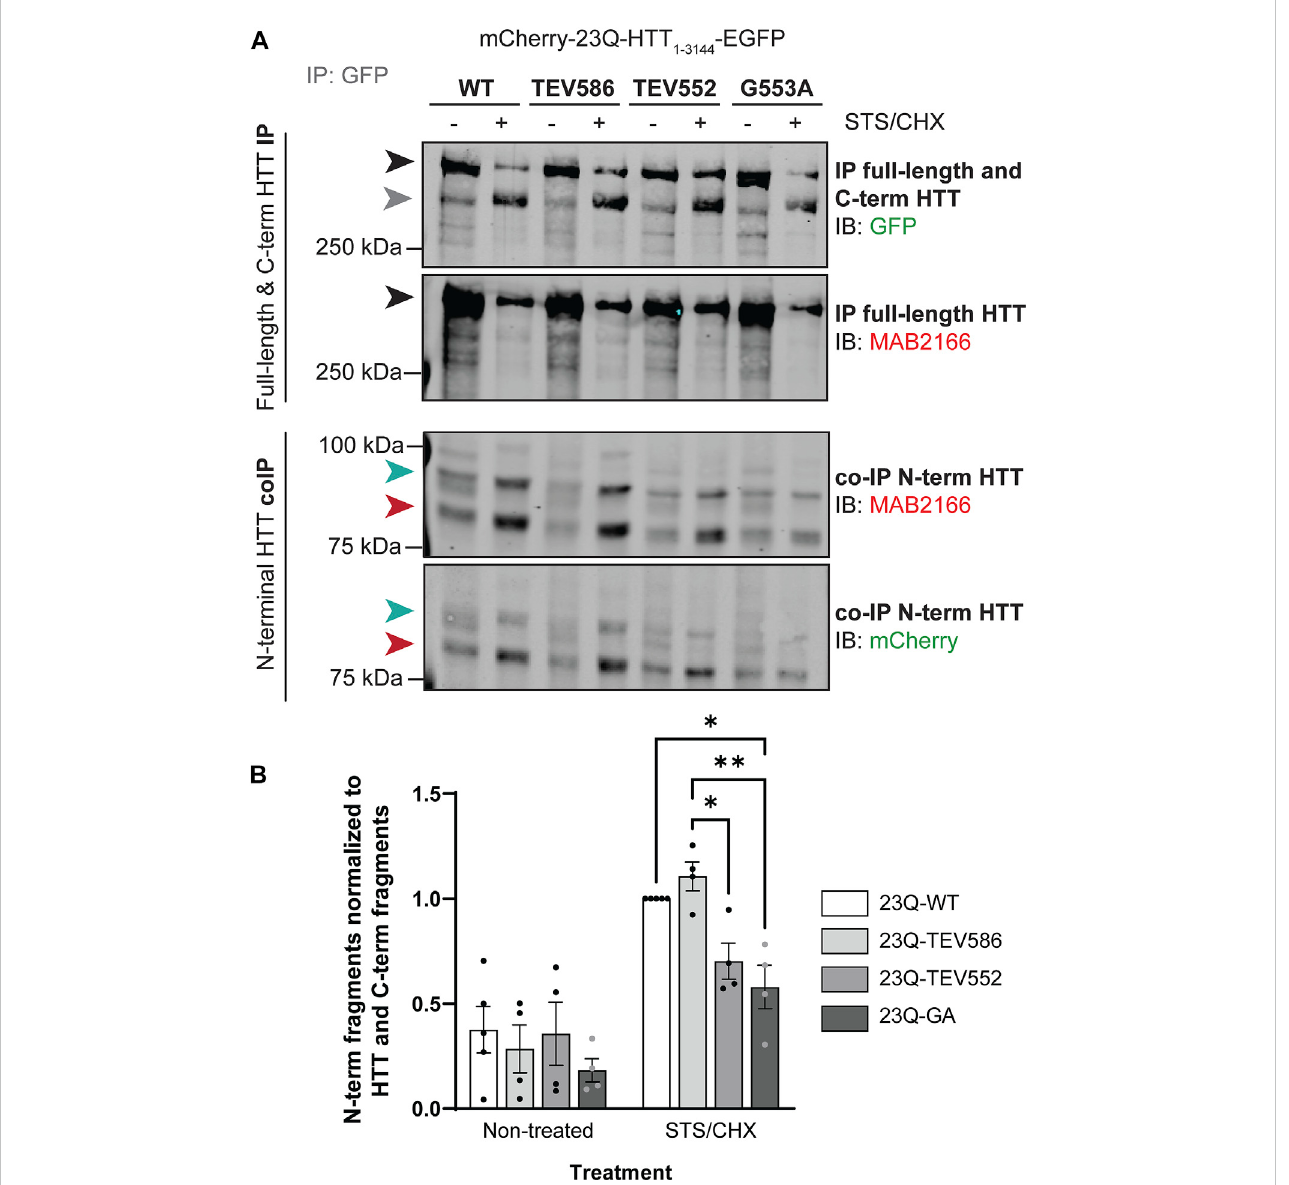
FIGURE 6 Blockingpost-translationalmyristoylationinfull-lengthwild-type HTTreducedtheinteractionbetweentheN-andC-terminalfragments. (A) HeLacells transientlyexpressingmCherry-23Q-HTT 1-3144 -EGFPWT,TEV586,TEV552orG553Afor46 hweretreatedfor2 hwith5 µMSTSand5 μ g/mLcycloheximide (STS/CHX) to induce proteolysis and inhibit protein synthesis, respectively. HTT-EGFP was immunoprecipitated from lysates with goat anti-GFP antibodies. Immunoblots were conducted with mouse anti-HTT (MAB2166; amino acid 443 – 457) and rabbit anti-GFP antibodies. Then, the membranes were stripped and re-probed with rabbit anti-mCherry antibodies. Full-length mCherry-23Q-HTT 1-3144 -EGFP, detected with GFP or MAB2166 antibodies, is indicated by a black arrowhead. C-terminal HTT-EGFP fragments, detected with GFP antibodies, are indicated by a grey arrowhead. The green and red arrowheads indicate the two main N-terminal mCherry-23Q-HTT fragments co-immunoprecipitated and detected by both mCherry and MAB2166 antibodies, with an apparent molecular weight of ~82 and 90 kDa, respectively, (B) interaction between N-terminal HTT fragments with full-length and C-terminal HTT was quanti fi ed as the ratio of the co-immunoprecipitated N-terminal HTT fragments detected with mCherry antibodies with molecular weights between 75 and 100 kDa normalized to the sum of immunoprecipitated full-length HTT and all C-terminal HTT fragments detected with GFP antibodies, and expressed relatively to 23Q-HTT WT in cells treated with STS (n = 4). Statistical analysis : 2-way ANOVA: interaction, p = .076; STS/CHX treatment, **** p < .0001; PTM mutation, ** p = .0076. Tukey ’ s multiple comparisons test: 23Q-WT vs. 23Q-G553A, * p = .017; 23Q-TEV586 vs. 23Q-TEV552, * p = .033; 23Q-TEV586 vs. 23Q-G553A, ** p =